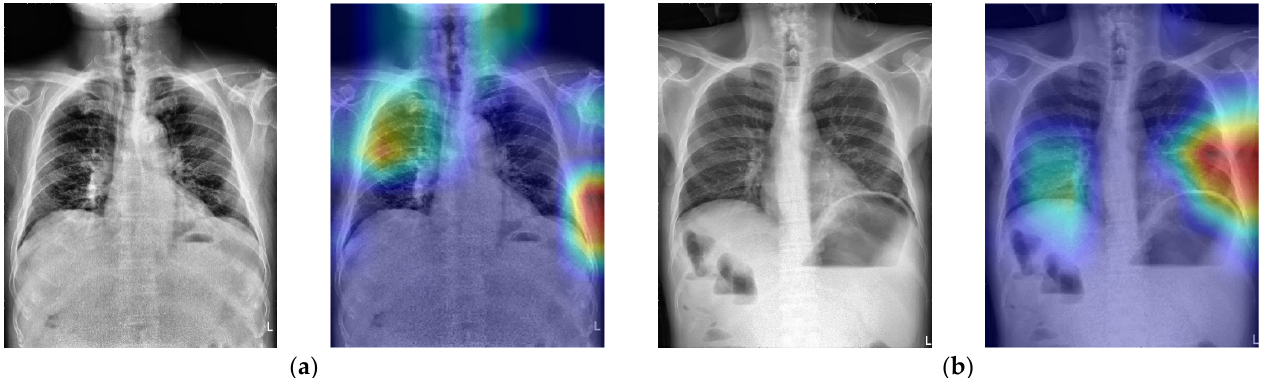
Figure 10. The raw X-ray images and the corresponding heatmaps of two FP cases ( a ) and ( b ). The deep model detected the “fake” dome signs that were caused by its contrast to intraluminal, rather than extraluminal, air of the gastrointestinal tract.